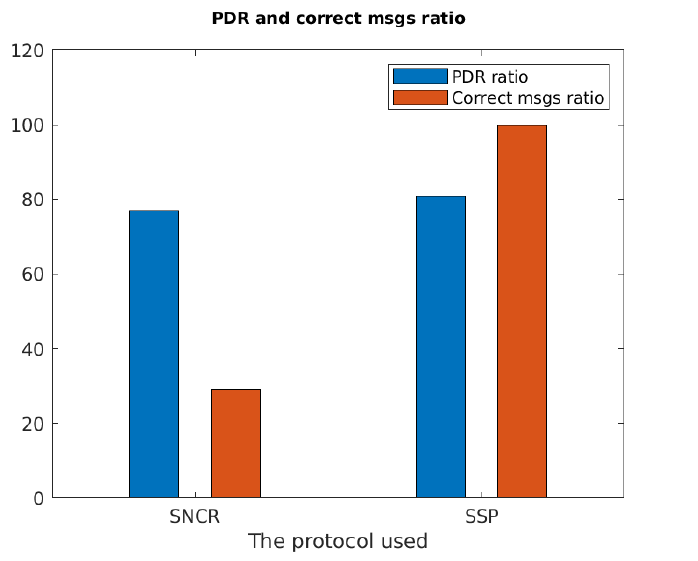
Figure 7. PDR and correct messages